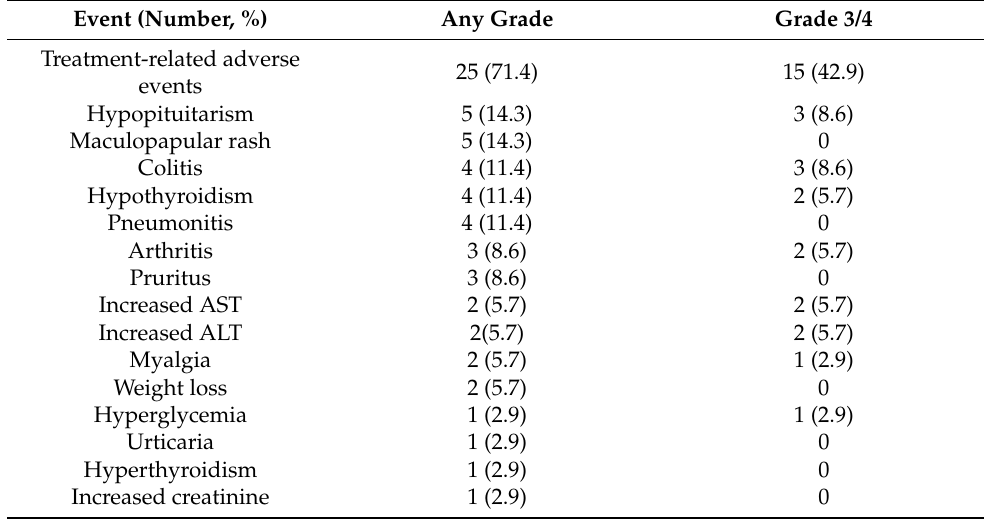
Table 4. Treatment-related adverse